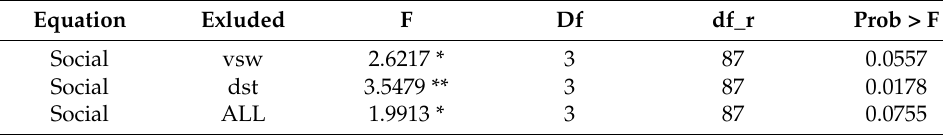
Table 2. Dpace weather and electricity consumption of the whole of society.